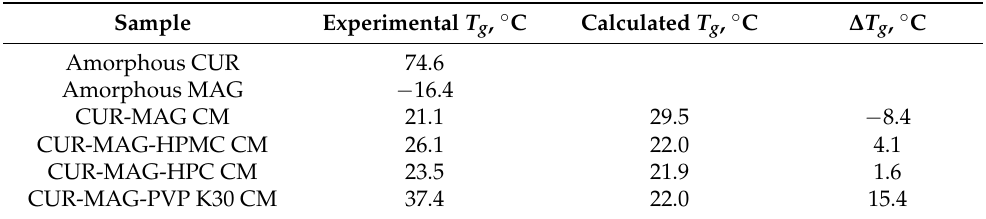
The experimental and theoretical T g values of CUR-MAG CM and its ternary co-amorphous systems.